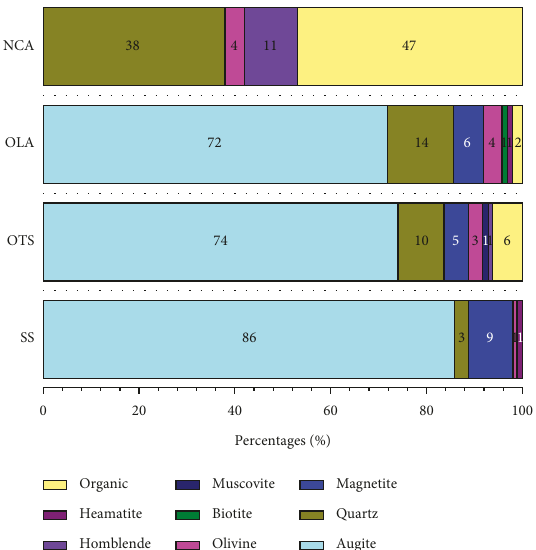
Figure 4: A plot of the average mineral proportions by the percentage of particles was determined by visual estimation in the samples taken from SS, OTS, OLA, and NCA.